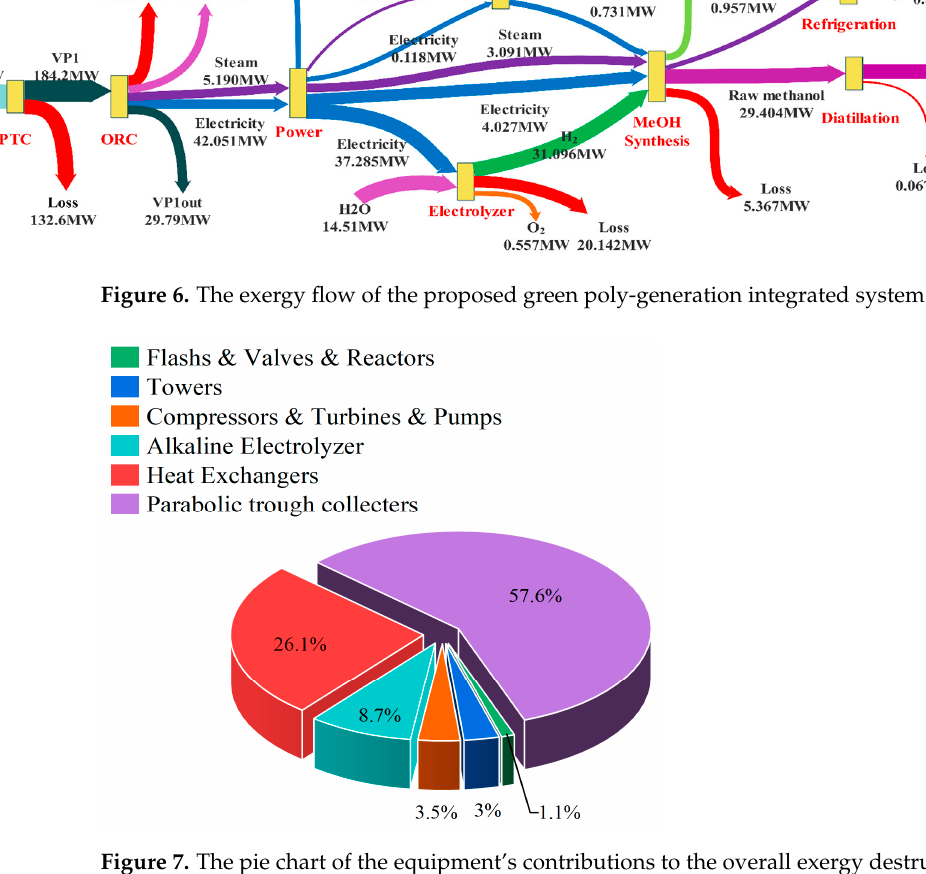
Figure 7. The pie chart of the equipment’s contributions to the overall exergy destruction.